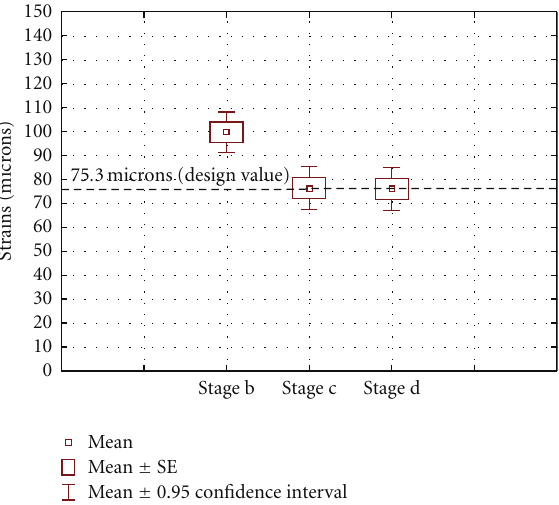
Figure 16: Average strains at the bottom of the base.